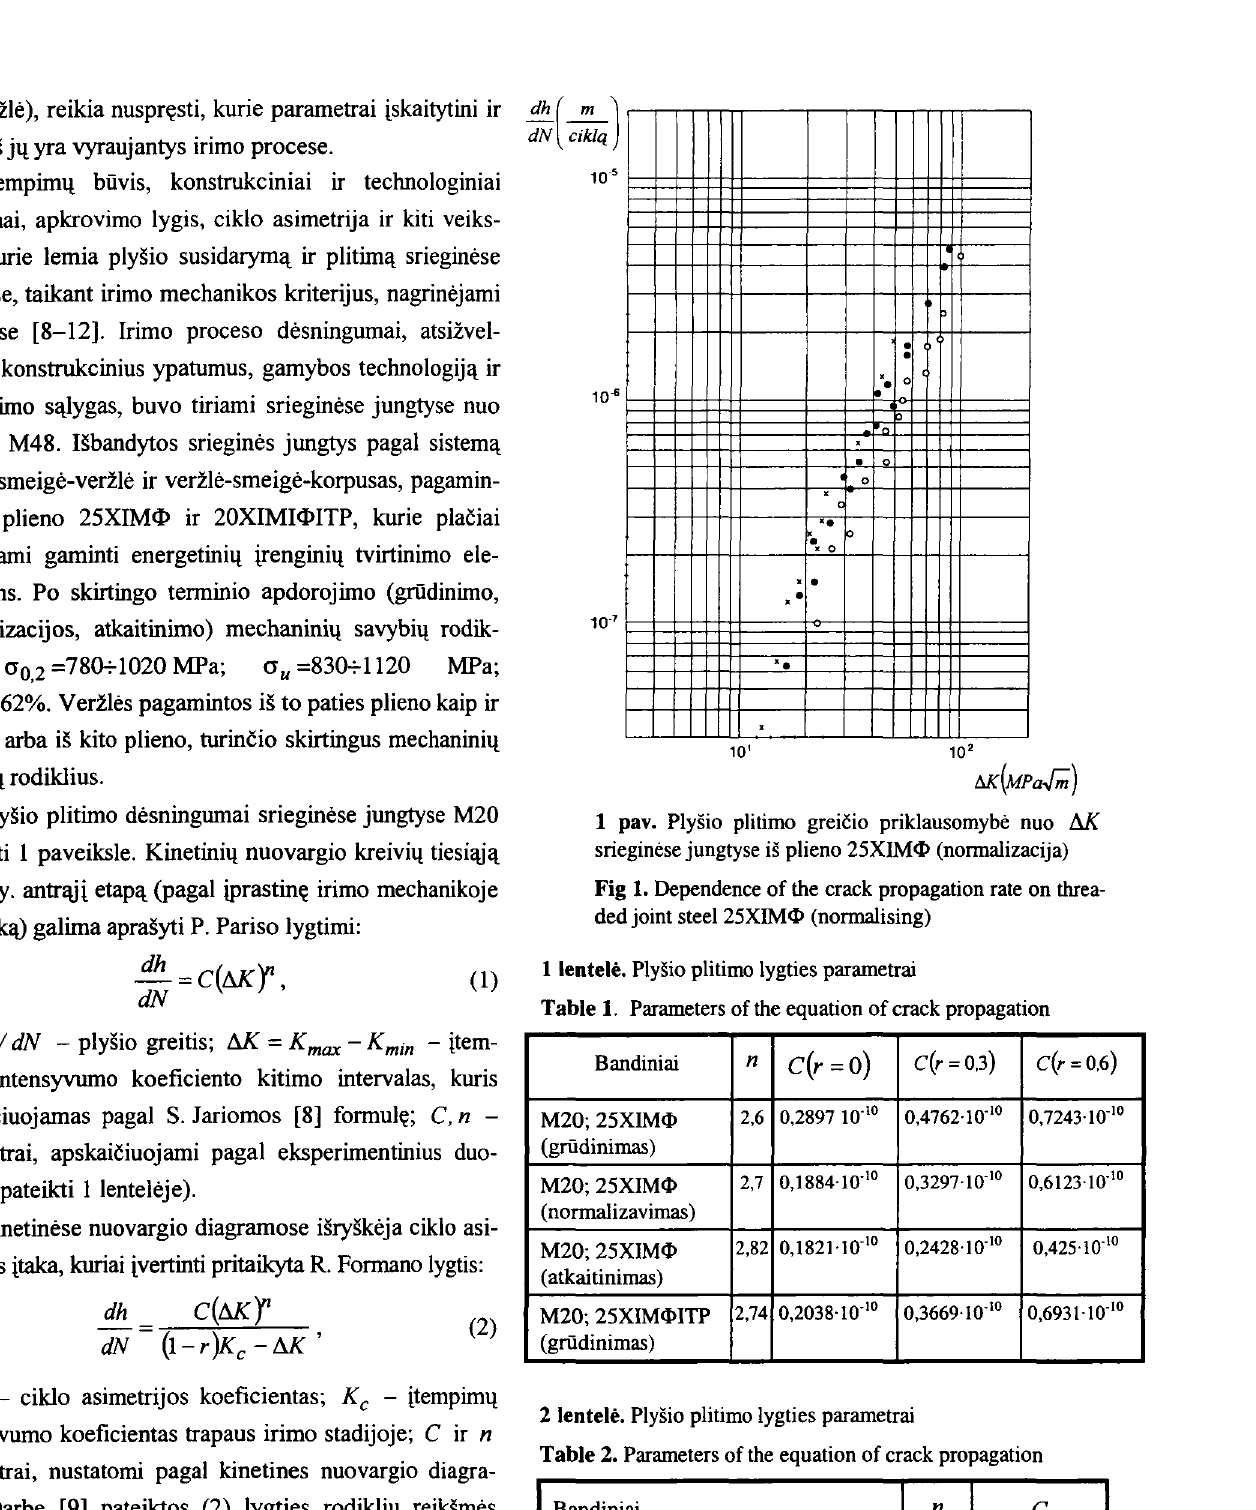
2 lentele. Plysio plitimo lygties parametrai Table 2. Parameters of the equation of crack